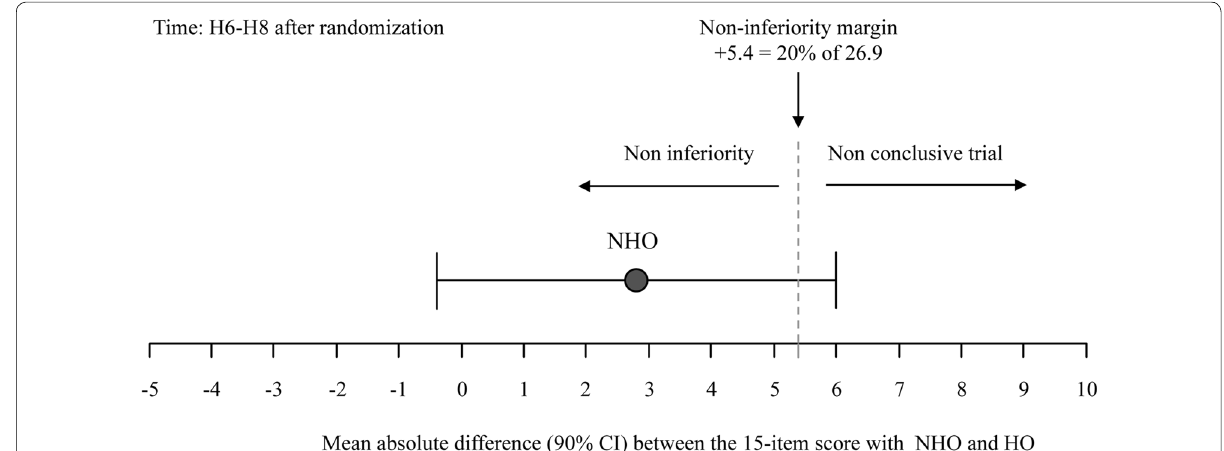
Fig. 2 Absolute difference (with confidence interval) between the 15-item comfort scores at H6–H8 after randomization between humidified oxygen (HO) and non-humidified (NHO) oxygen. The non-inferiority margin was within the 90% CI of the absolute difference, meaning that the non-inferiority analysis was not